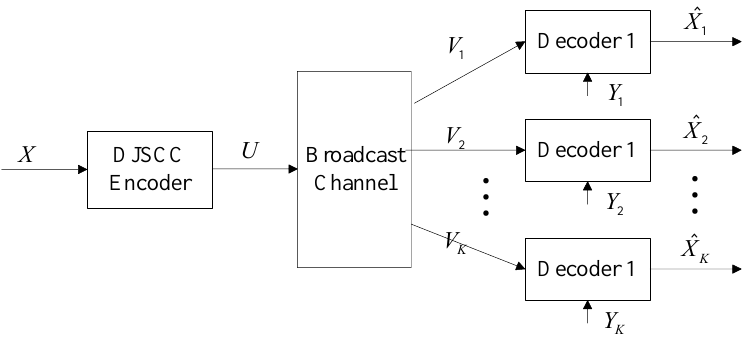
Figure 5. The system model of DJSCC for the BC